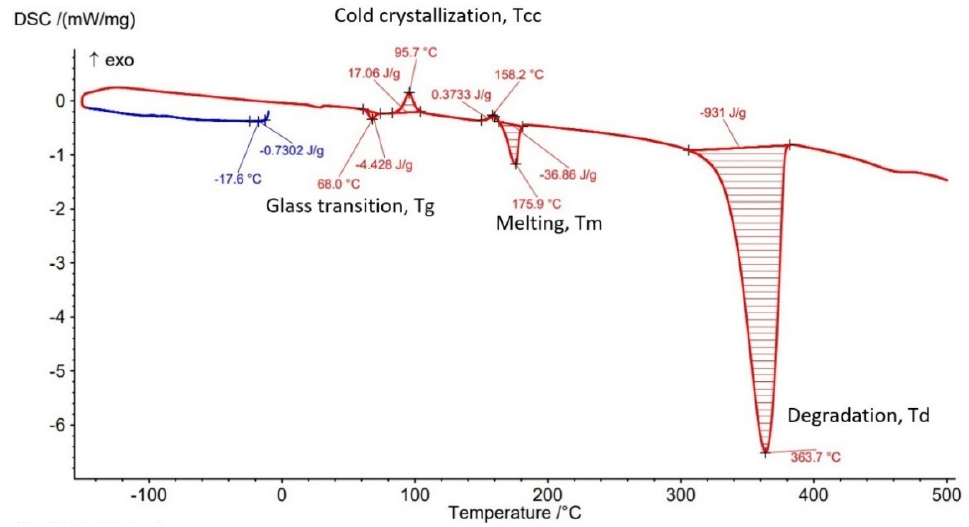
Figure 9. DSC thermogram for sample with 50% infill density.